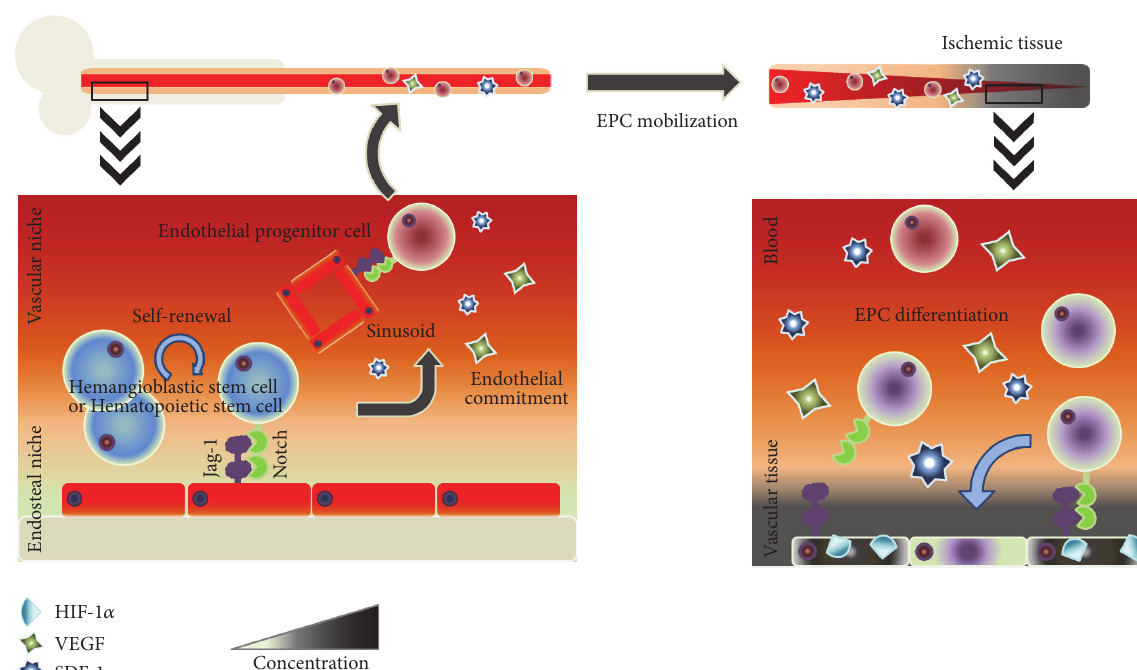
Figure 1: EPC homing from a BM niche to the circulation. HSCs and EPCs interact with stromal niche cells via Notch signals. HIF-1 𝛼 , stabilized from ischemic signals, promotes EPC homing-related cytokines, including VEGF and